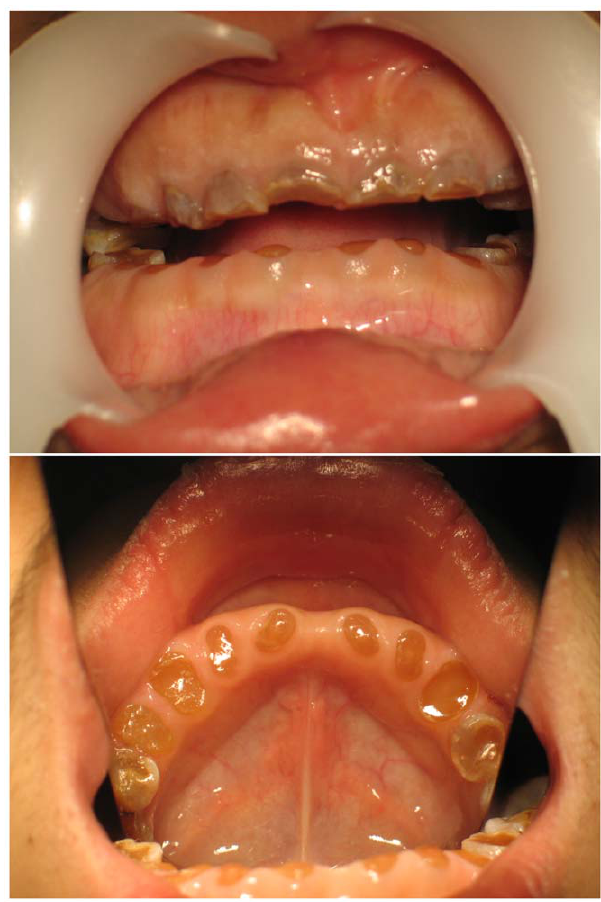
Figure 2. Clinical manifestations of the proband IV 12 .